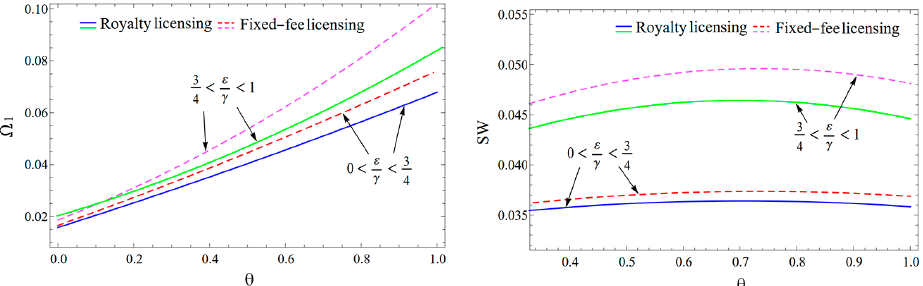
Figure 2. Optimal licensing strategies for patent holder in the precent of